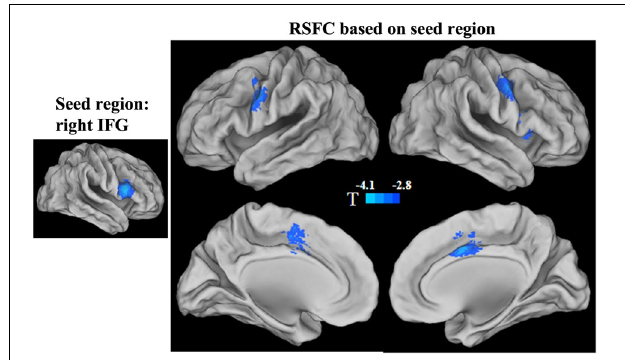
FIGURE 3 | Statistical significance ( T -score) of the correlation with the GRP score for the strength of functional connectivities in the right IFG seed region. The cool color represents a negative